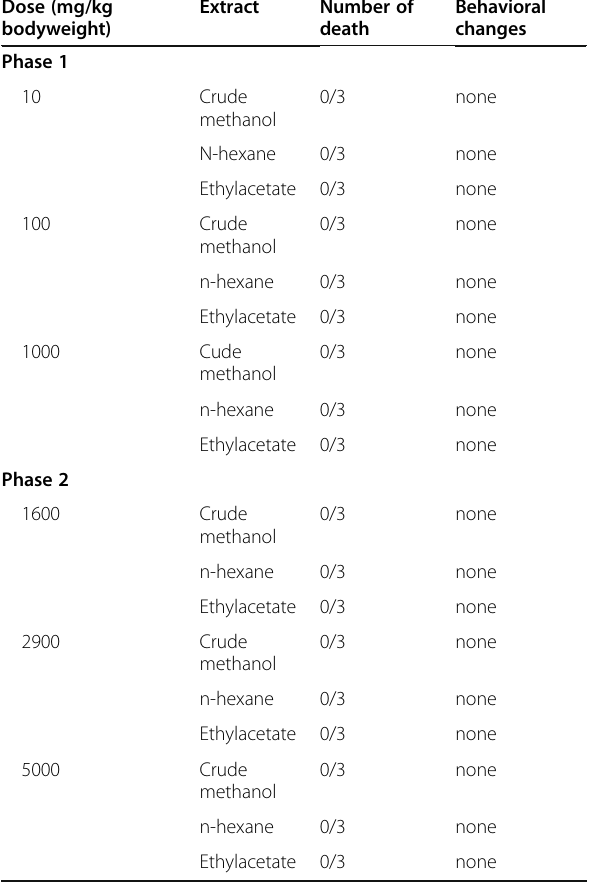
Table 2 Acute oral toxicity of Gymnema sylvestre plant extracts in rats